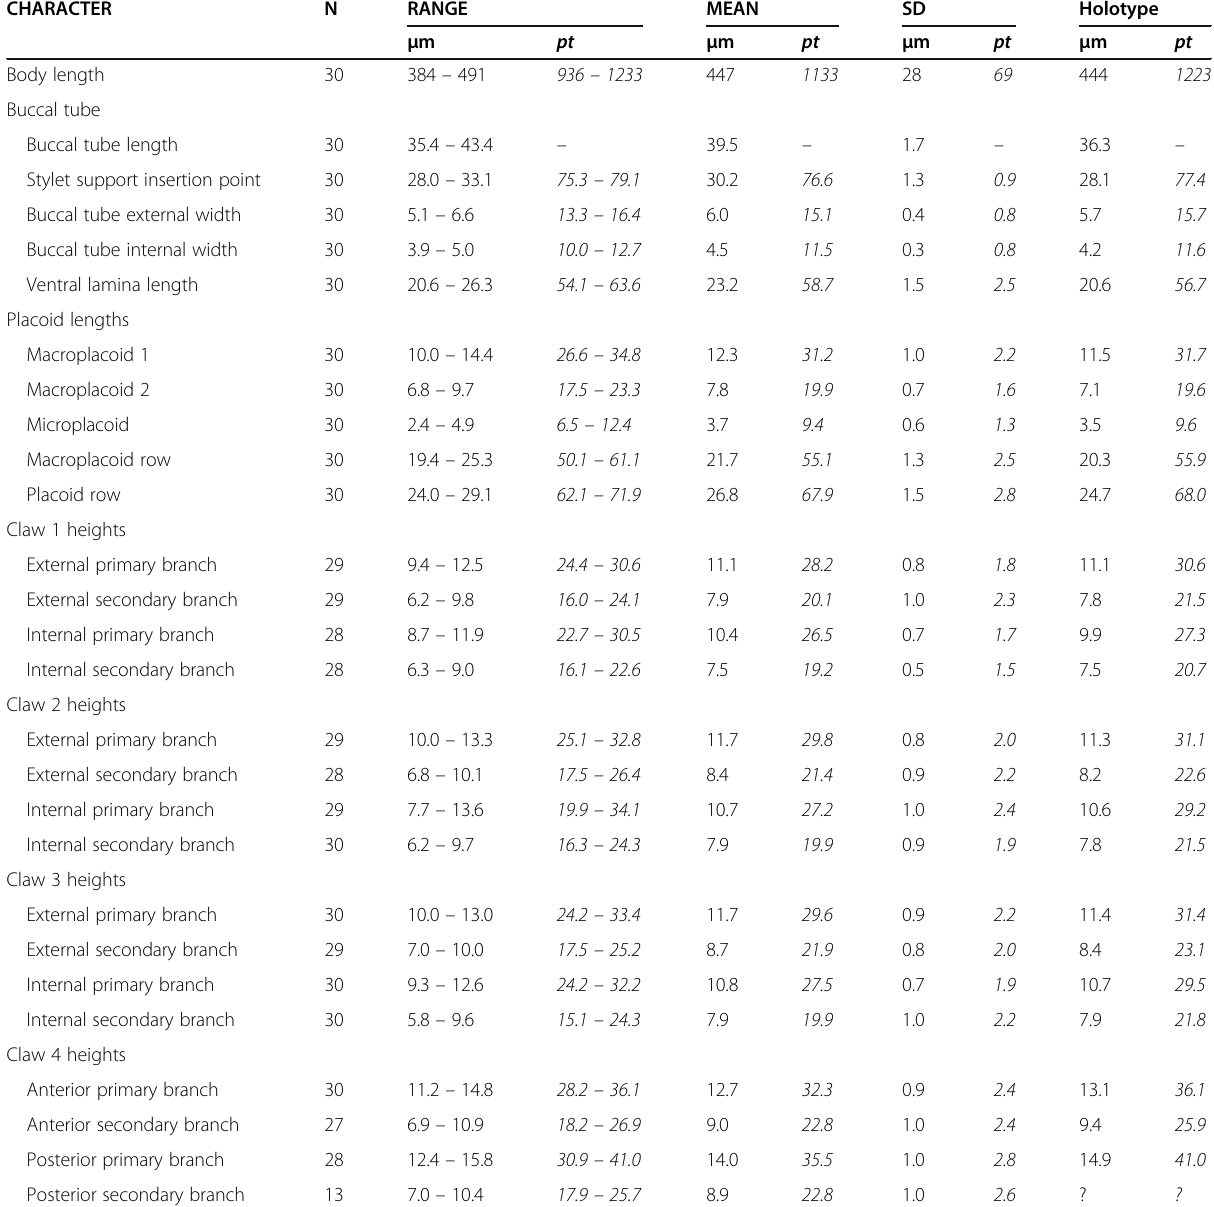
Table 10 Measurements [in μ m] of selected morphological structures of individuals of Macrobiotus ripperi sp. nov. from Poland (PL.015) mounted in Hoyer ’ s medium (N – number of specimens/structures measured, RANGE refers to the smallest and the largest structures among all measured specimens; SD – standard